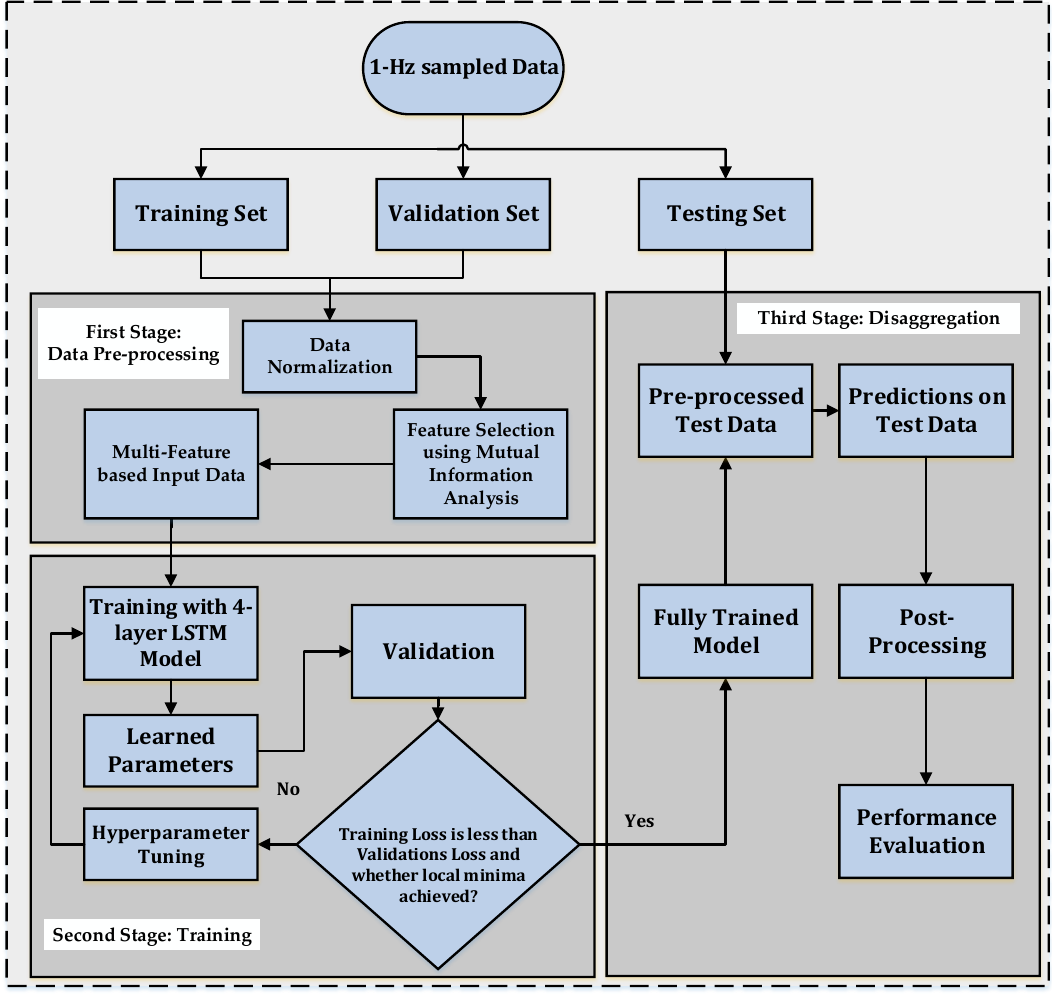
Figure 1. Proposed architecture of the three-stage multi-feature input space (MFS)- long short-term memory (LSTM) algorithm.